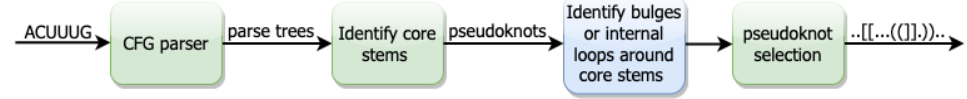
Figure 3. Overview of the Knotify+ proposed